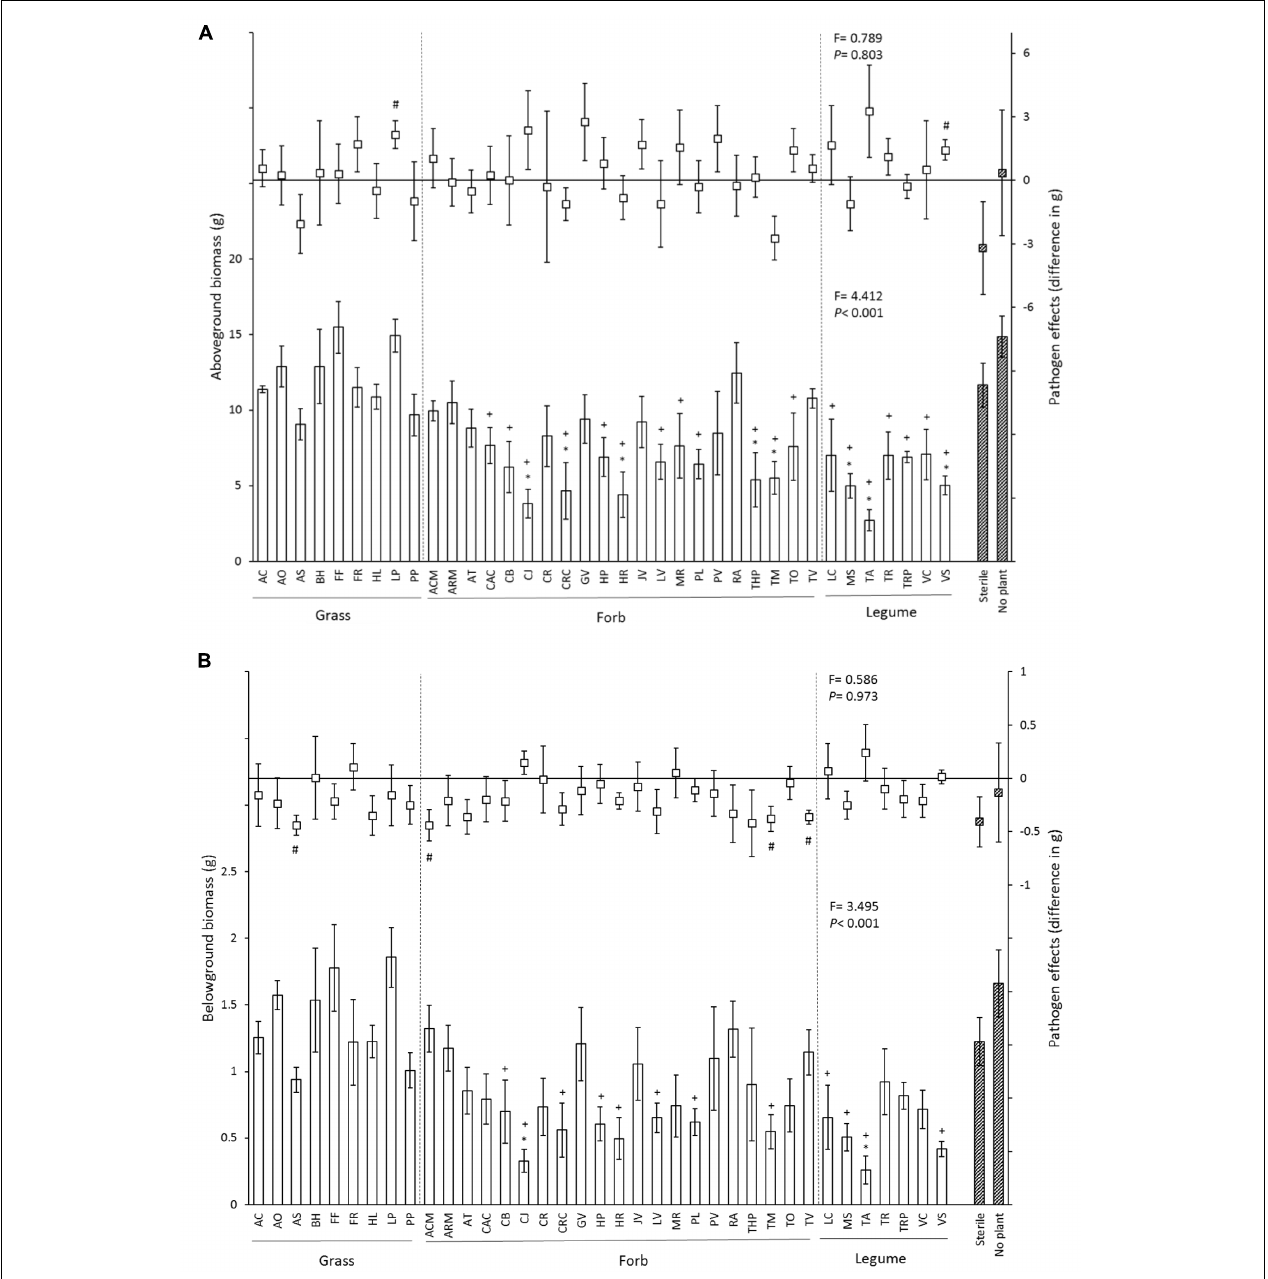
FIGURE 1 | Effects of 37 species-specific soil inocula, no plant inoculum and sterile soil on chrysanthemum aboveground biomass (A) and belowground biomass (B) . In each figure, bars represent chrysanthemum biomass (mean ± SE) of soil inocula in control soil, and squares represent the pathogen effect on plant biomass (biomass in P. ultimum soil – biomass in non- Pythium inoculated soil). Striped bars indicate controls. “ ∗ ” Represents significant difference from the sterile soil ( P < 0.05). “+” Represents significant difference from the no plant soil inoculum ( P < 0.05), “#” represents significantly different from zero ( P < 0.05). Dashed lines separate soil inocula into different functional groups. Species abbreviations are given in Table 1 . Statistics presented in the lower part of each panel represent the effects of soil on chrysanthemum biomass in control soil, and statistics presented in the upper part of each panel indicate the effects of soil inocula on the disease severity of chrysanthemum